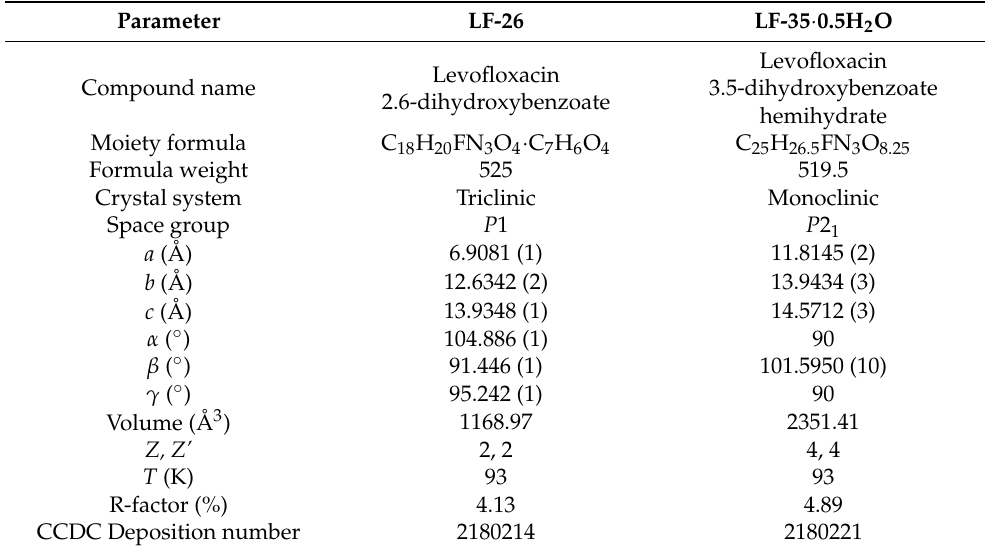
Table 1. Crystallographic data and refinement details of LF-2,6-DHBA and LF-3,5-DHBA.